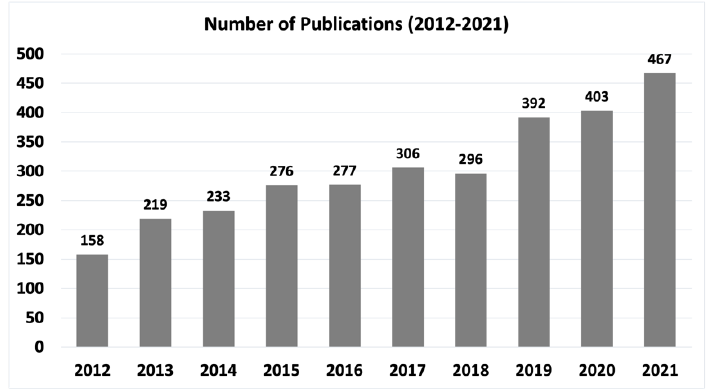
Figure 1. Magnetic nanoparticle publications in Scopus as of December 2021. Table 1. Advantages and pitfalls of magnetic nanoparticles for MFH therapy. Advantage Improvement Required As theranostics Improvement in large-scale synthesis techniques Development of simple functionalization techniques with the Improved Biocompatibility and use of biodegradable materials Biodegradation Targeting ability The detailed understanding of immune interaction is required Manipulated by Magnetic Field Batch after Batch